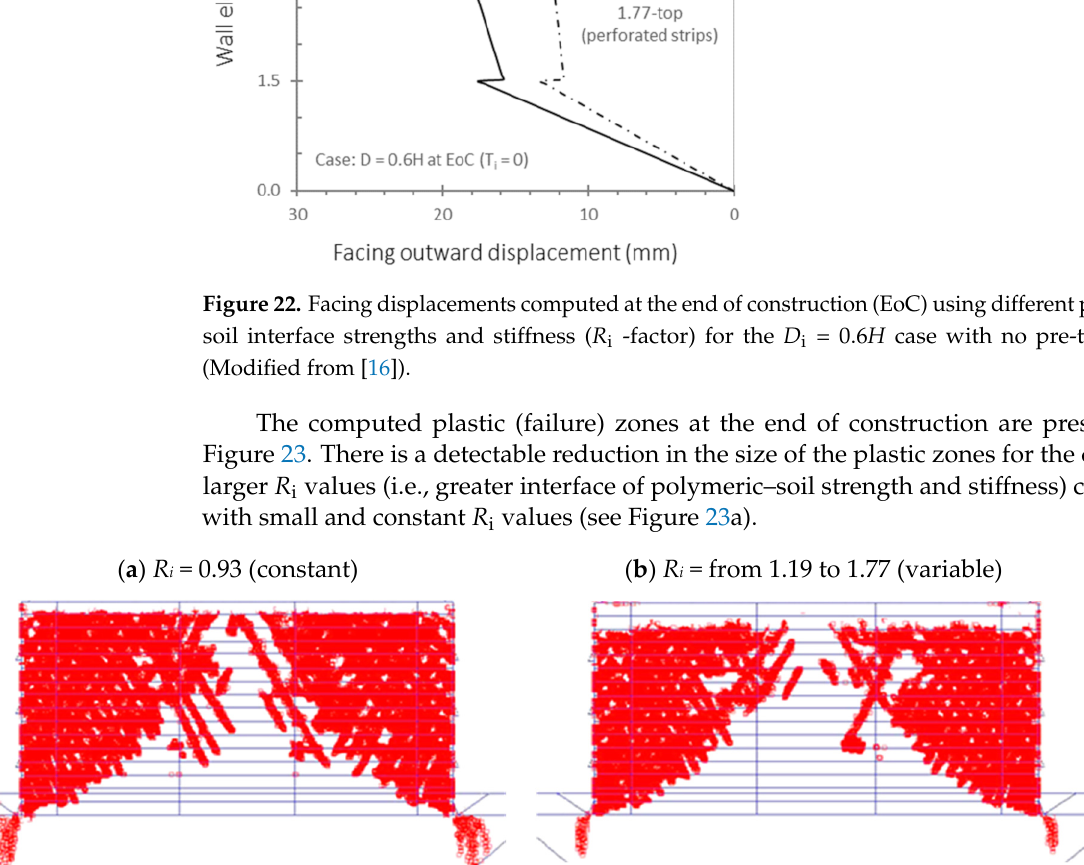
Figure 23. Plastic zones (Mohr-Coulomb points) at end of construction for D i = 0.6 H case with no pre-tensioning and polymeric–soil interface factor assumptions: ( a ) R i = 0.93 (constant), and ( b ) R i = from 1.19 to 1.77 (variable). (Note: white zones on top of the models represent tension cut-off points location). (Modified from [16]).